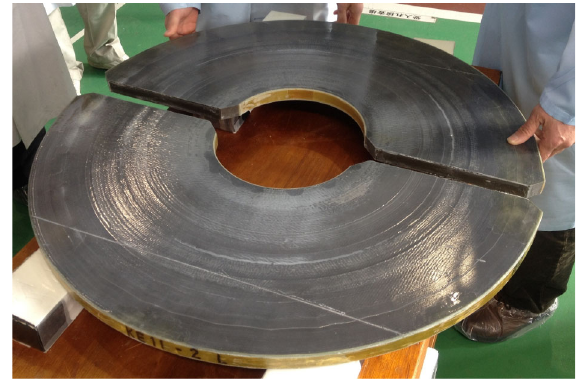
FIG. 6. The FT3L cut core before diamond